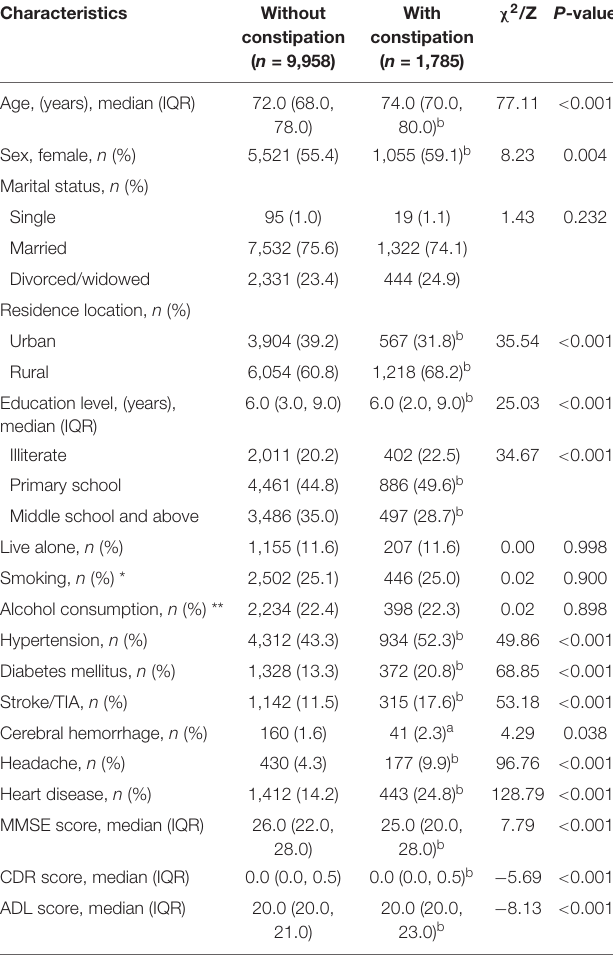
TABLE 1 | Characteristics of the study population by